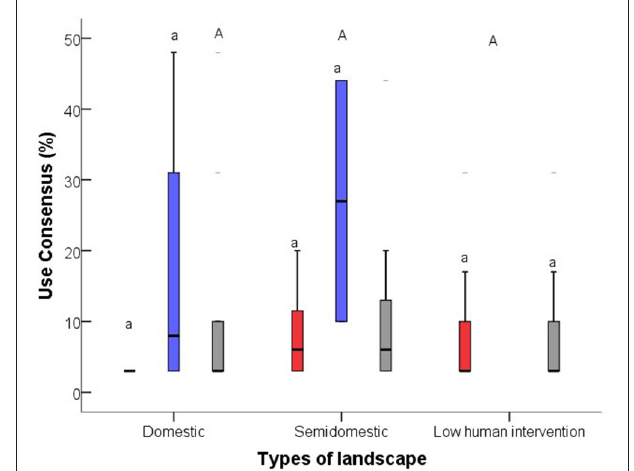
FIGURE 3 | Average richness of combustible species cited by inhabitants according to landscape categories (domestic, semi-domestic and low human intervention) and biogeographic origin. Key: (cid:4) Native species; (cid:4) Exotic species; (cid:4) Total number. Different letters indicate significant differences.